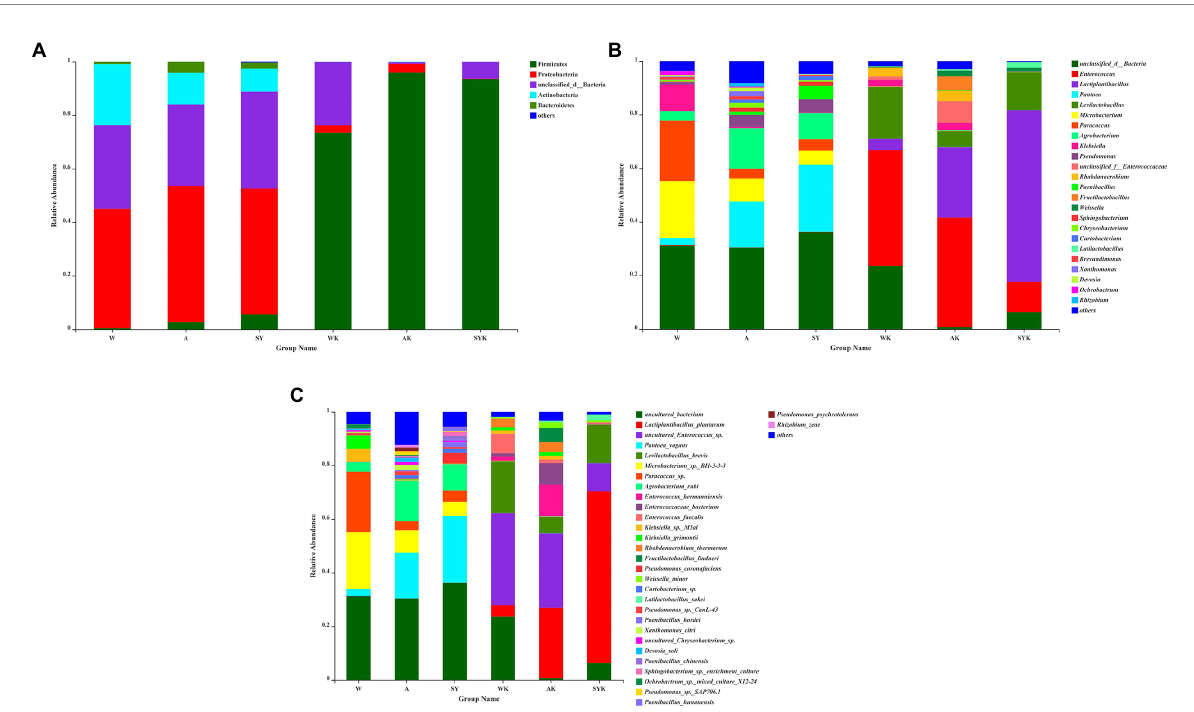
FIGURE 4 Bacterial community composition on phylum (A) , genus (B) , and species (C) level in fresh ryegrass and ryegrass silage by SMRT. W, Raw materials of Ordos-wushenqi; A, Raw materials of Hohhot; SY, Raw materials of Ulanqab-siziwangqi; WK, Ryegrass silages of Ordos-wushenqi; AK, Ryegrass silages of Hohhot; SYK, Ryegrass silages of Ulanqab-siziwangqi.